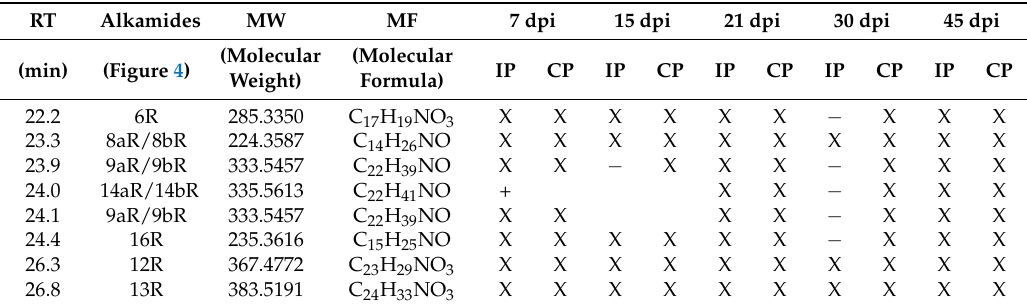
plants and absent in inoculated plants; (+) Alkamide present only in inoculated plants. Table 4. Chemical profile of root extracts of Cingapura cultivar: inoculated plants (IP) and control plants